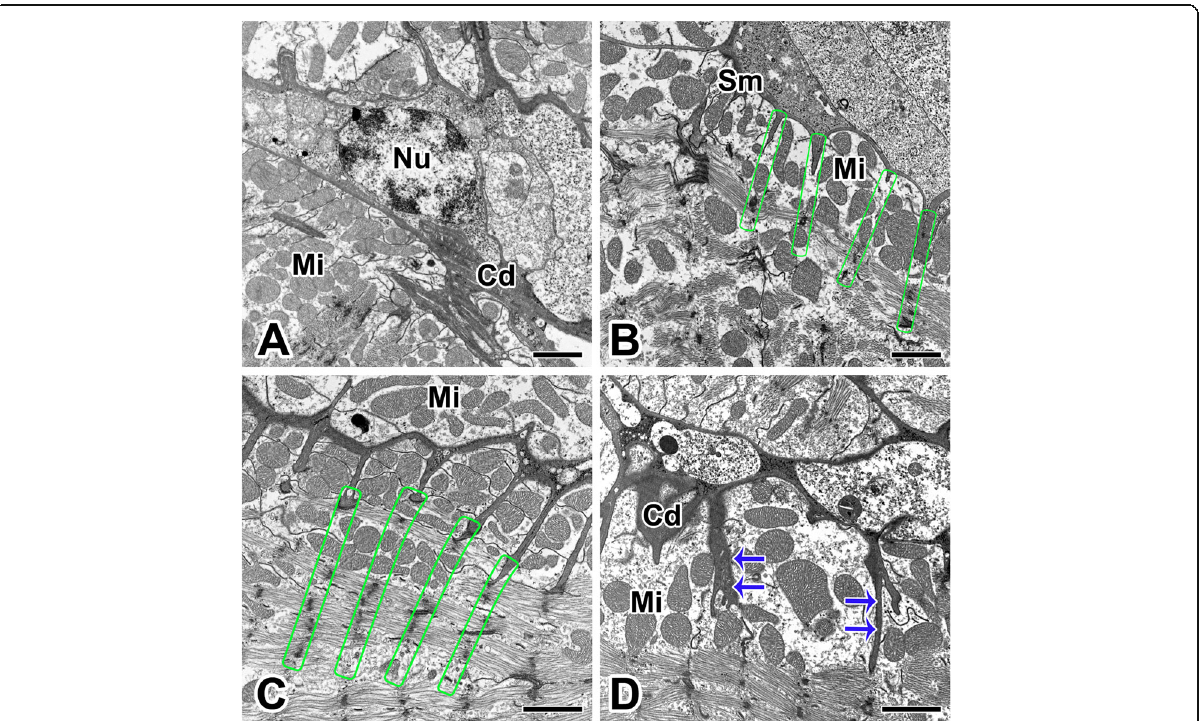
Fig. 2 Transmission electron micrographs of the intercalated discs of the cardiac muscles in L. mactans. a : The intercalated disc (Cd) at the ends of muscle cells consist of extensive folds and intercellular junctions. b : Each muscle fiber contains plenty of mitochondria (Mi) for cardiac contraction. Each rectangle represents the location of Z-line of sarcomeres. c : The sarcolemma (Sm) of the intercalated disc shows a scalloped appearance with Z-line connections to sarcolemmal membranes (rectangles). d : Intercalated discs are part of the cardiac muscle sarcolemma and they contain a network of cellular junctions (arrows). Nu: nucleus. All scale bar indicates 2 μ